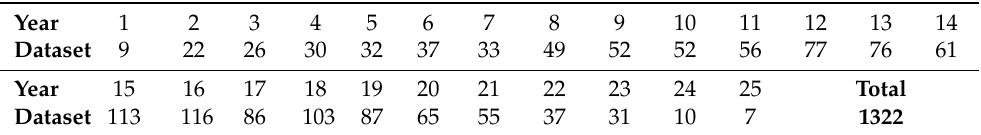
Table 1. Dataset distribution for each